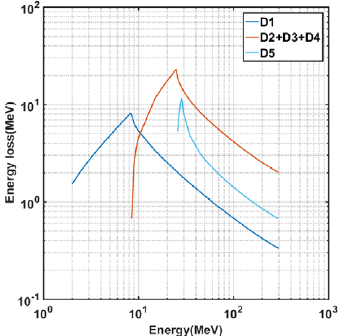
Figure 9. Energy loss curves of protons in semiconductor sensors.